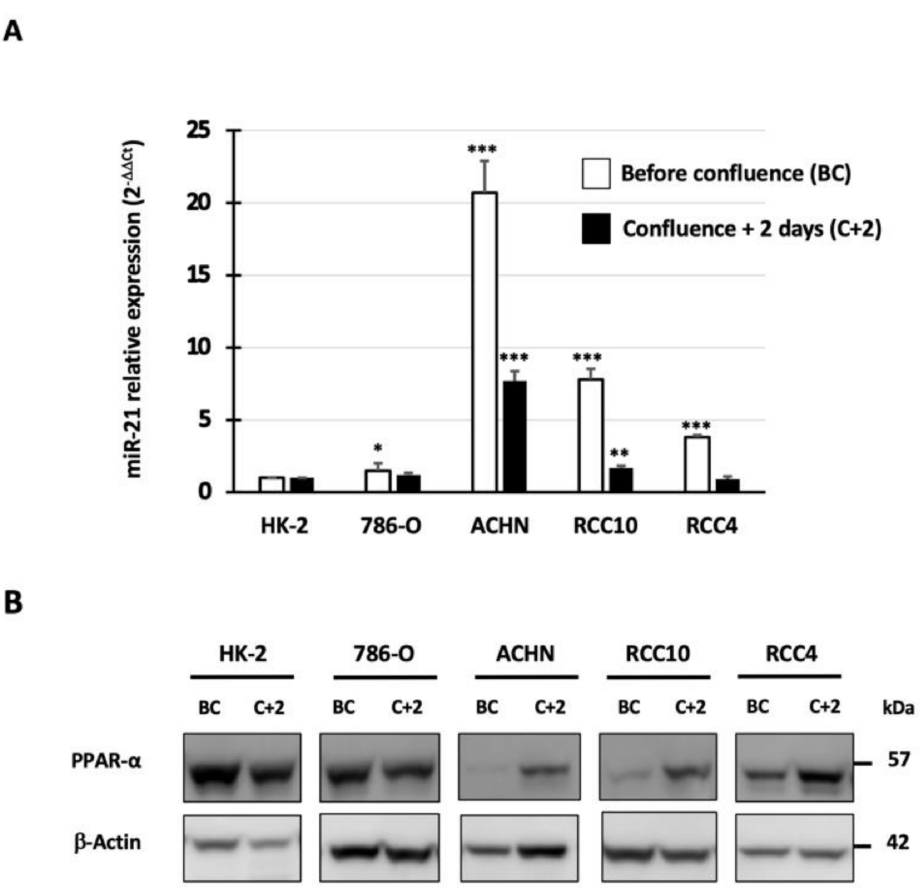
Figure 2. miR-21 and PPAR- α expressions in HK-2 and renal cancer cell lines before confluence (BC) and two days after confluence (C + 2). ( A ) Using RT-qPCR, miR-21 expression was determined in the 786-O, ACHN, RCC10, and RCC4 renal cancer cells as compared to normal HK-2 renal epithelial cells. RNU48 was used as an internal control. The values are means ± SEM and represent at least three separate experiments (* p < 0.05, ** p < 0.01, and *** p < 0.001). ( B ) Western blotting was performed on whole cell extracts. Antibodies against PPAR- α and β -actin were